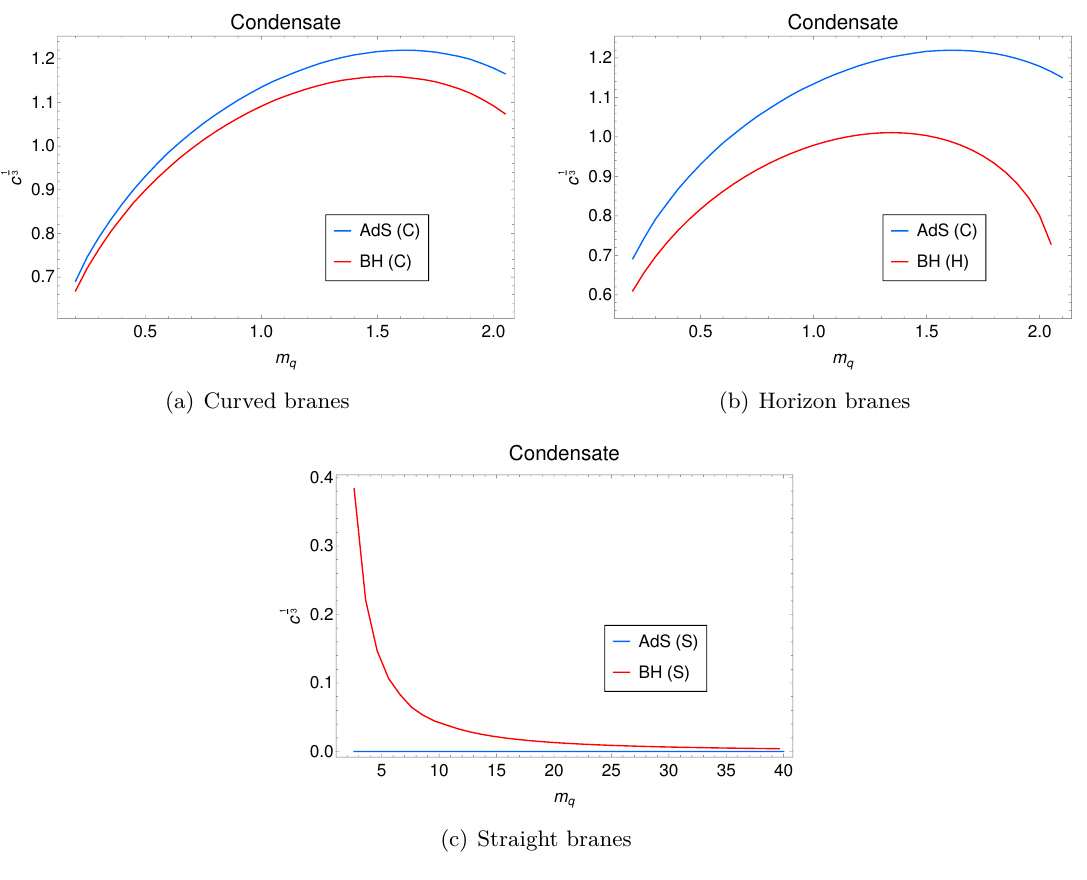
Figure 20 . Condensate as a function of